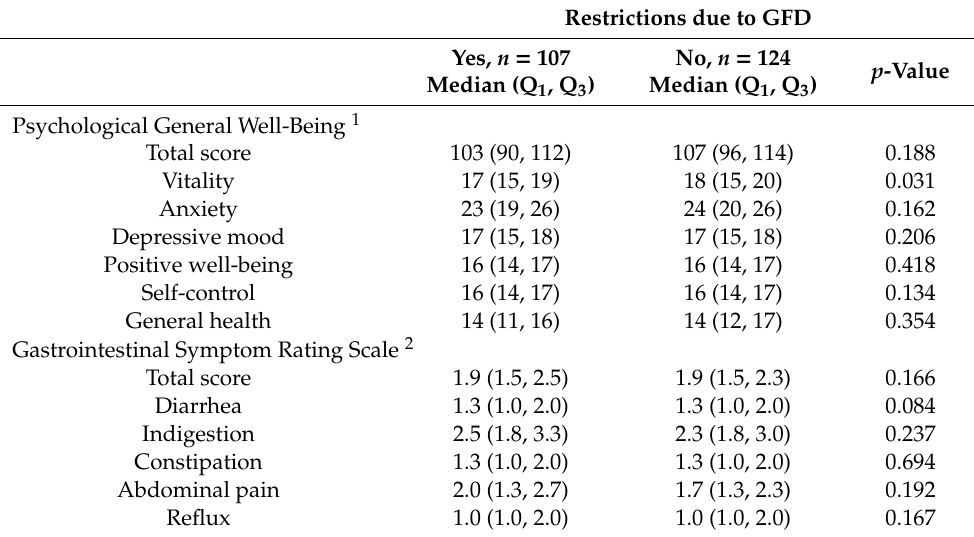
Table 4. Current quality of life and gastrointestinal symptoms of 231 adults diagnosed with celiac disease in childhood with and without daily life restrictions caused by a gluten-free diet